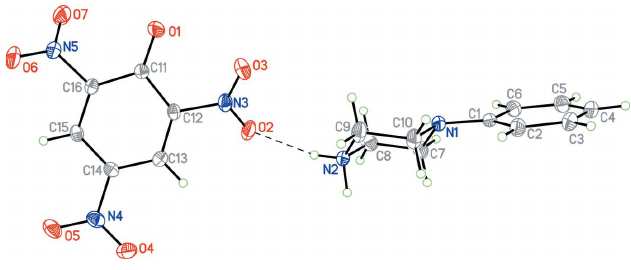
Figure 7 The molecular structure of 8 with hydrogen bonds shown as dashed lines. Atomic displacement parameters are at the 30% probability level.